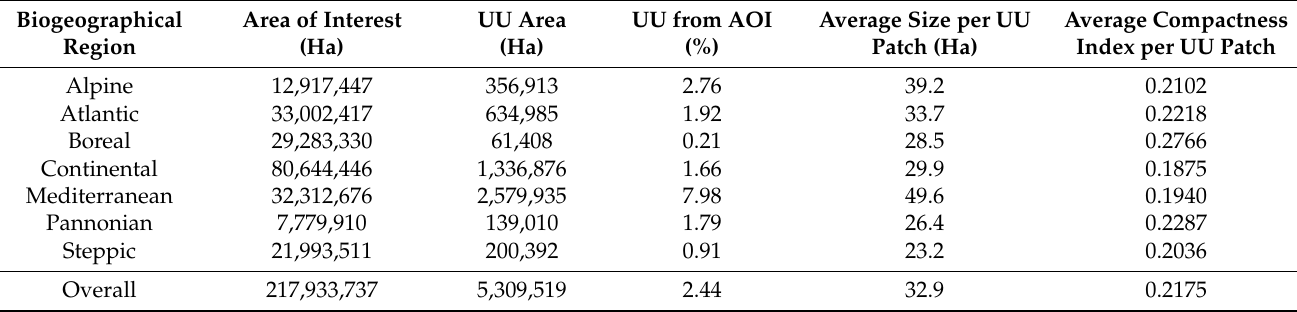
Table 2. Area of interest, UU areas, as well as average size and average compactness index of UU land patches per biogeographical